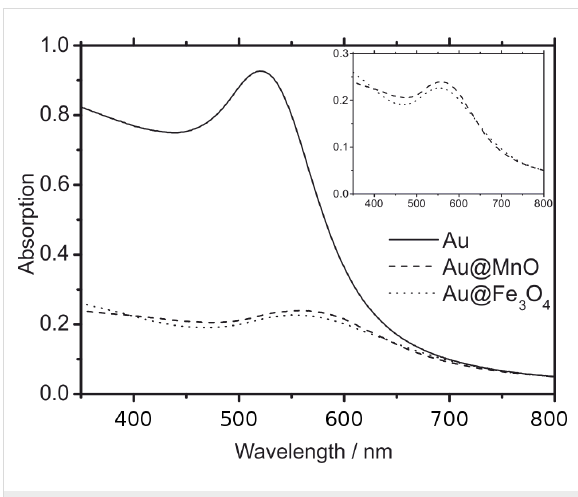
Figure 11: UV–vis spectra of Au (solid), Au@MnO (dashed), and Au@Fe 3 O 4 (dotted) nanoparticles normalized to the absorption at 800 nm.